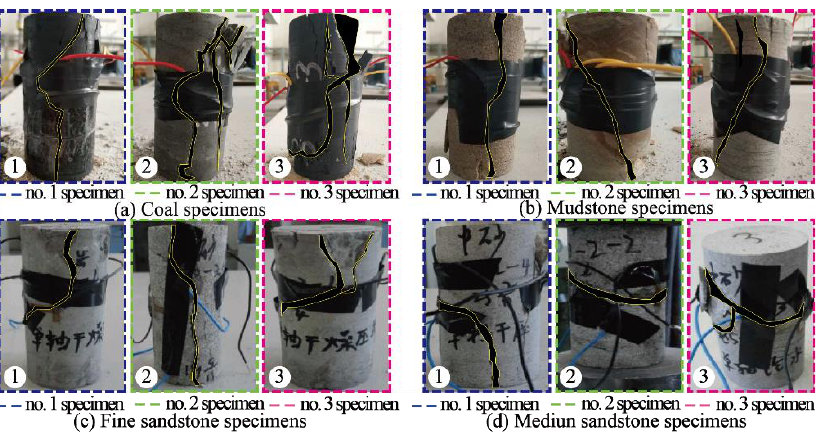
Figure 6. Failure state of rock specimens and samples.